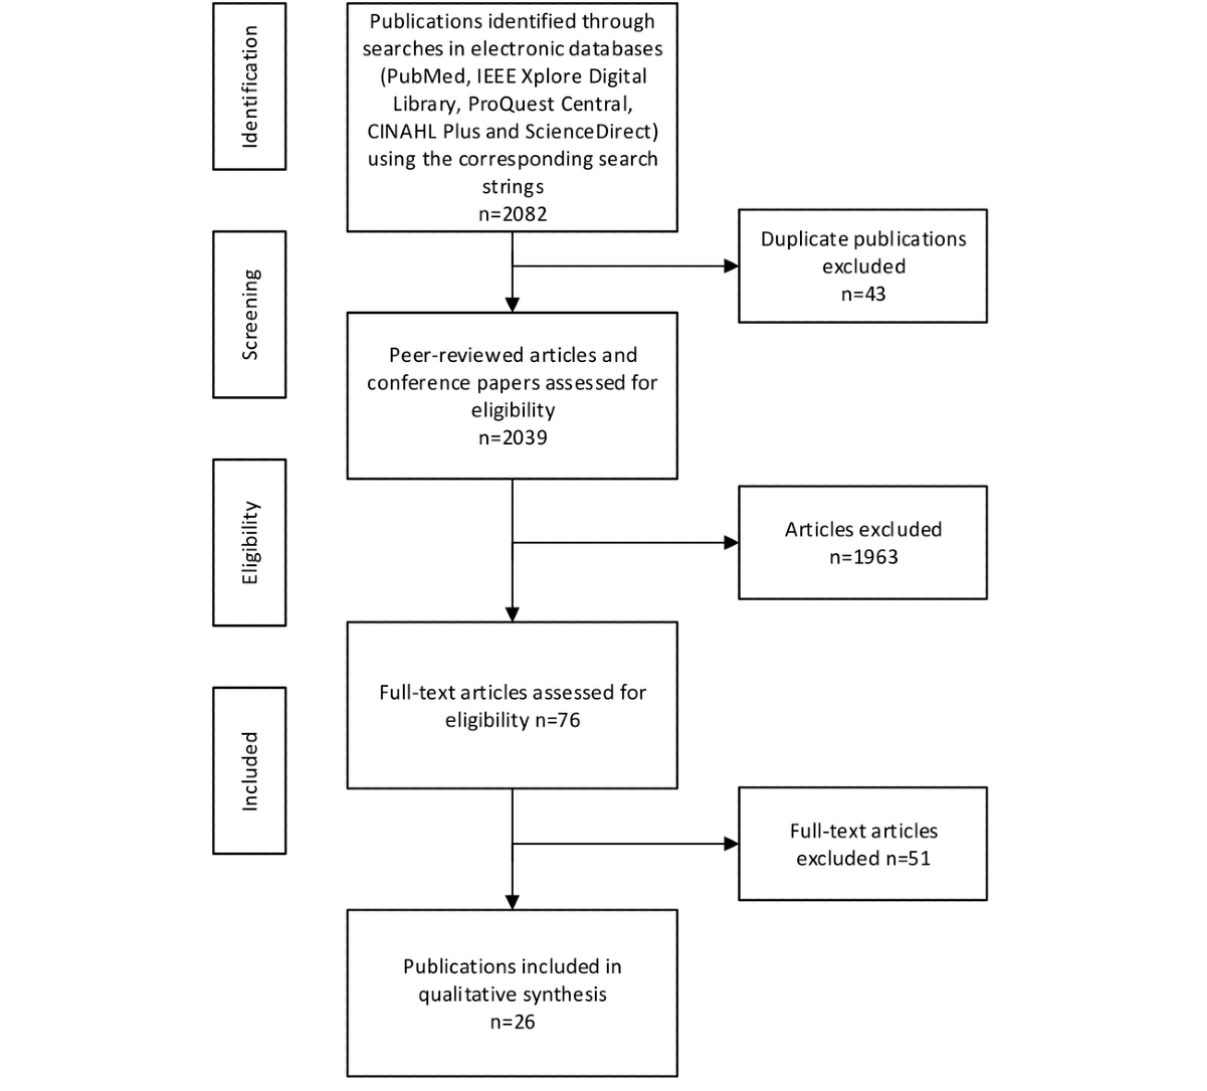
Figure 3. Search methodology. CINAHL: Cumulative Index to Nursing and Allied Health Literature; IEEE: Institute of Electrical and Electronics